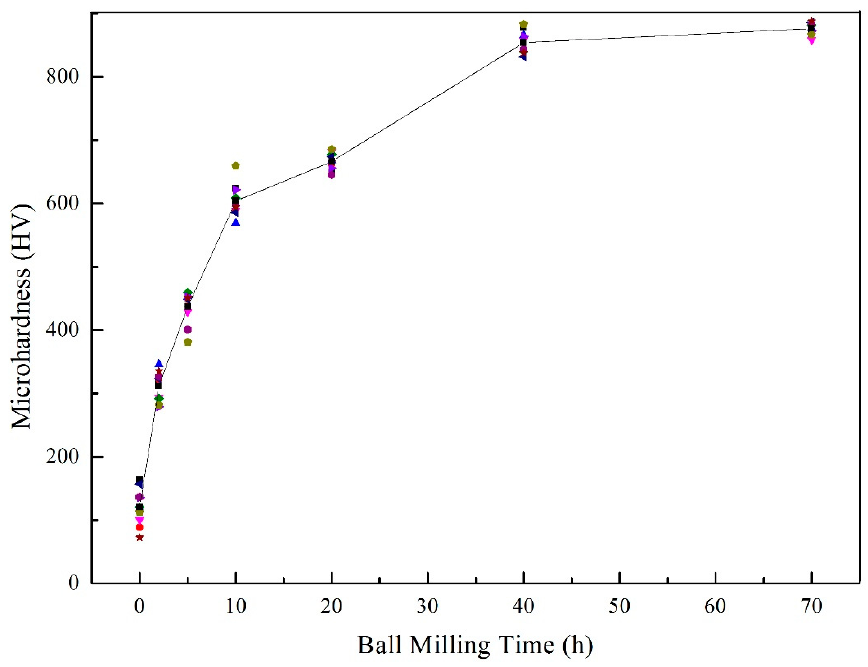
Table 1. SD and RSD of the hardness value under different milling times.